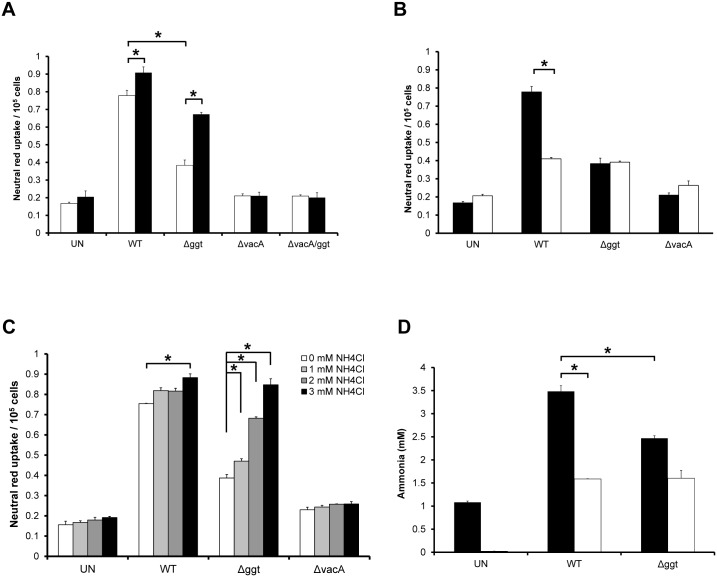

H. pylori GGT potentiates VacA-dependent vacuolation induction in gastric epithelial cells through glutamine hydrolysis.(A) AGS cells were co-cultured with H. pylori WT, Δggt, ΔvacA, ΔvacA/ggt (□) and/or rGGT (■) for 24 hours. Untreated cells (UN) served as control. (B) AGS cells were co-cultured with WT, Δggt or ΔvacA at MOI 1:100 for 24 hours in the presence (■) or absence (□) of 2mM glutamine. (C) AGS cells were co-cultured with WT, Δggt or ΔvacA at MOI 1:100 for 24 hours in the absence or presence of 1-3mM ammonium chloride. The cells were then subjected to neutral red dye uptake assay. (D) AGS cells were co-cultured with H. pylori WT or Δggt for 24 hours in the presence (■) of 2mM glutamine or in glutamine-free media (□). Concentration of ammonia in the spent culture media was measured using an ammonia assay kit. Experiments were performed in triplicates and values represent the means ± SD from 3 independent experiments. *P<0.05.